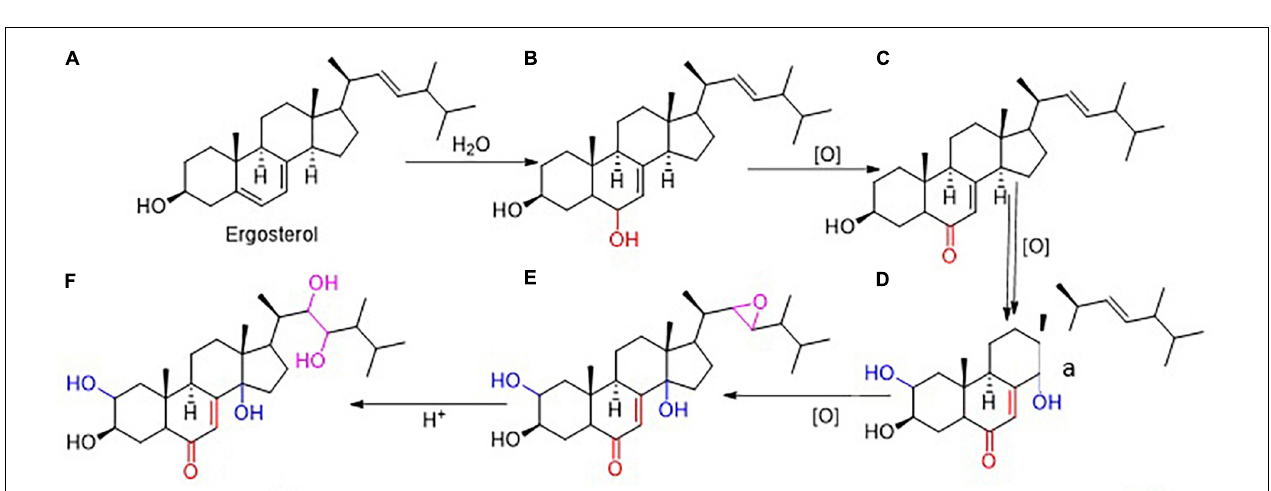
FIGURE 4 | Validation of the DEGs related to ergosterol synthesis expression using qRT-PCR. The ERG6 encoded by comp16933_c0 , the ERG2 encoded by comp34626_c0 and the ERG5 encoded by comp32446_c0 all presented up-regulated 6.71 (A) , 3.93 (B) and 2.42 (C) folds, respectively, in the QR group. * stands for P < 0.05, in comparison to that of the control group.